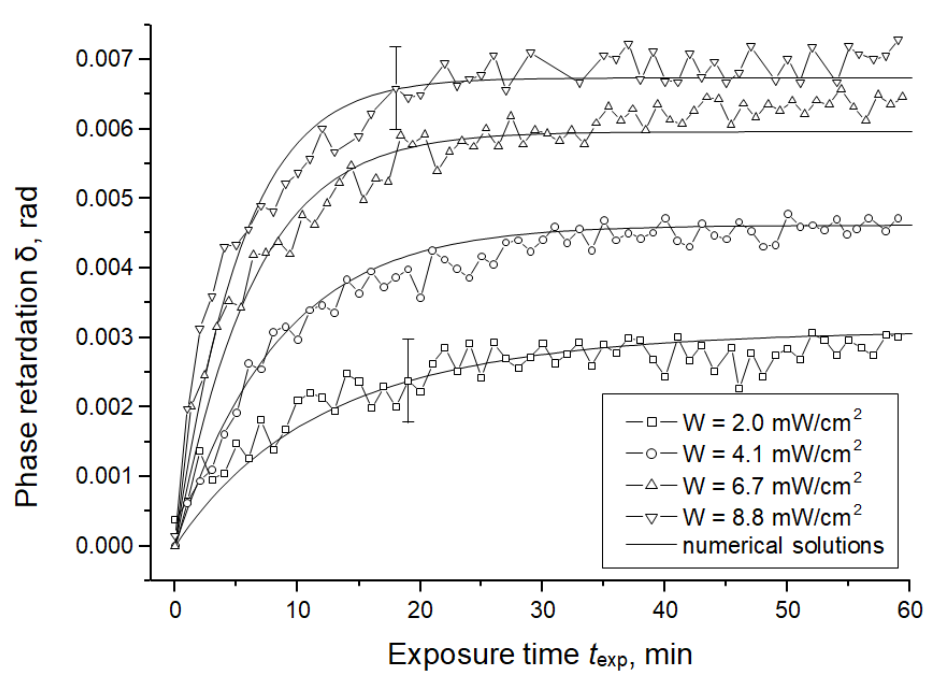
Figure 2. Dependence of photoinduced phase retardation on the exposure time for various powers per unit area ( W ) of the irradiated UV-light. Solid lines indicate numerical solutions, which were obtained by using rotational diffusion model.